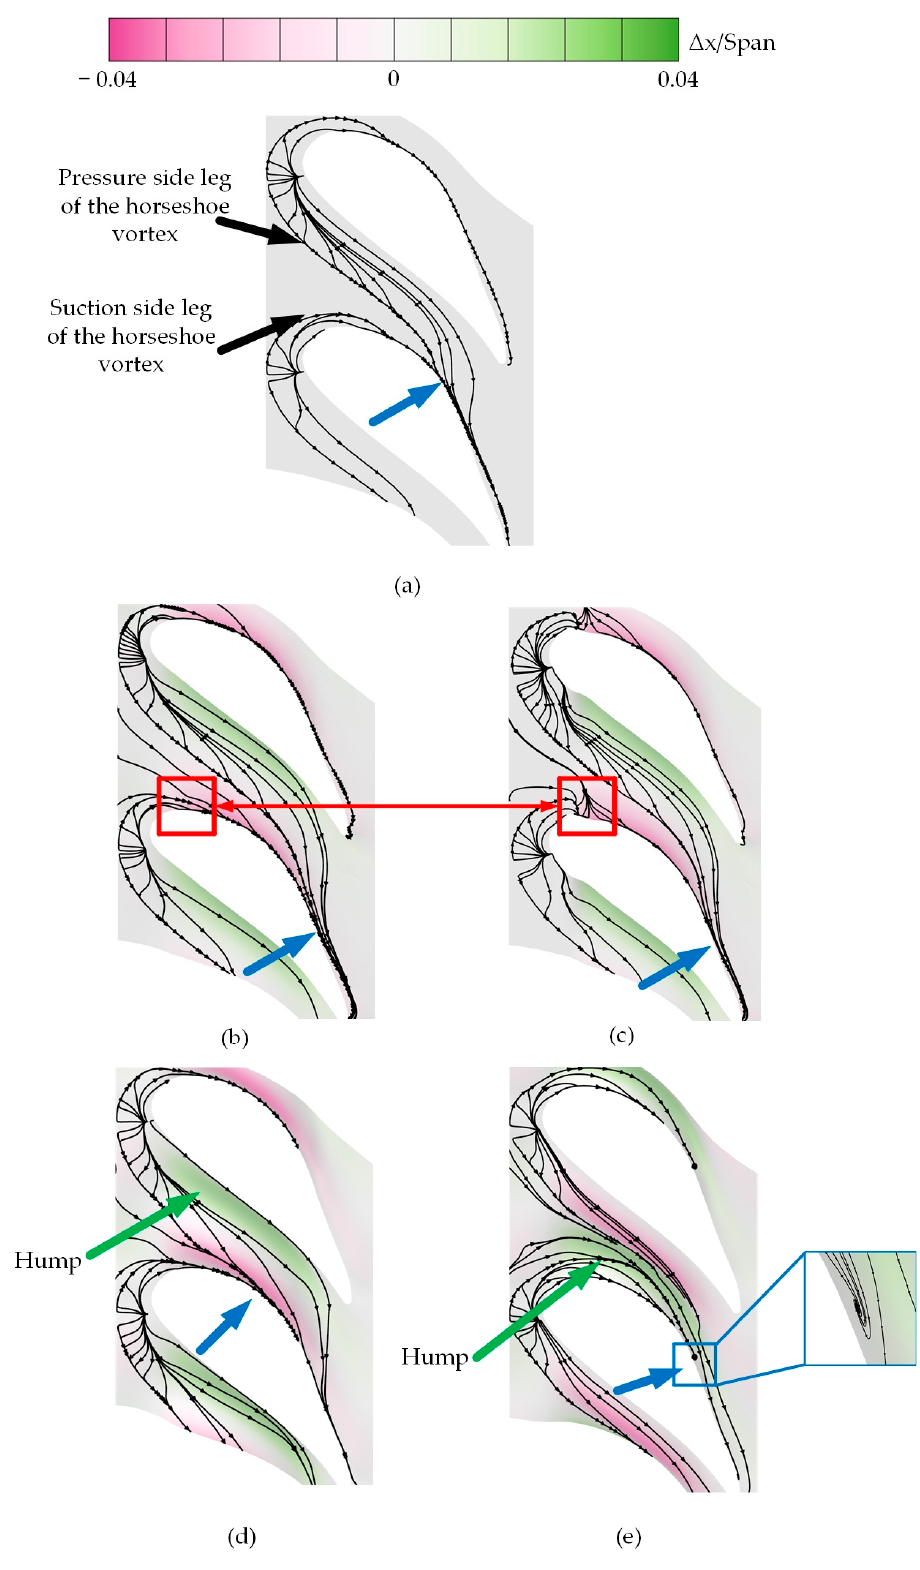
Figure 9. Limiting streamlines on the endwall. ( a ) Initial contour. ( b ) Case 1. ( c ) Case 2. ( d ) Case 3. ( e ) Case 4.